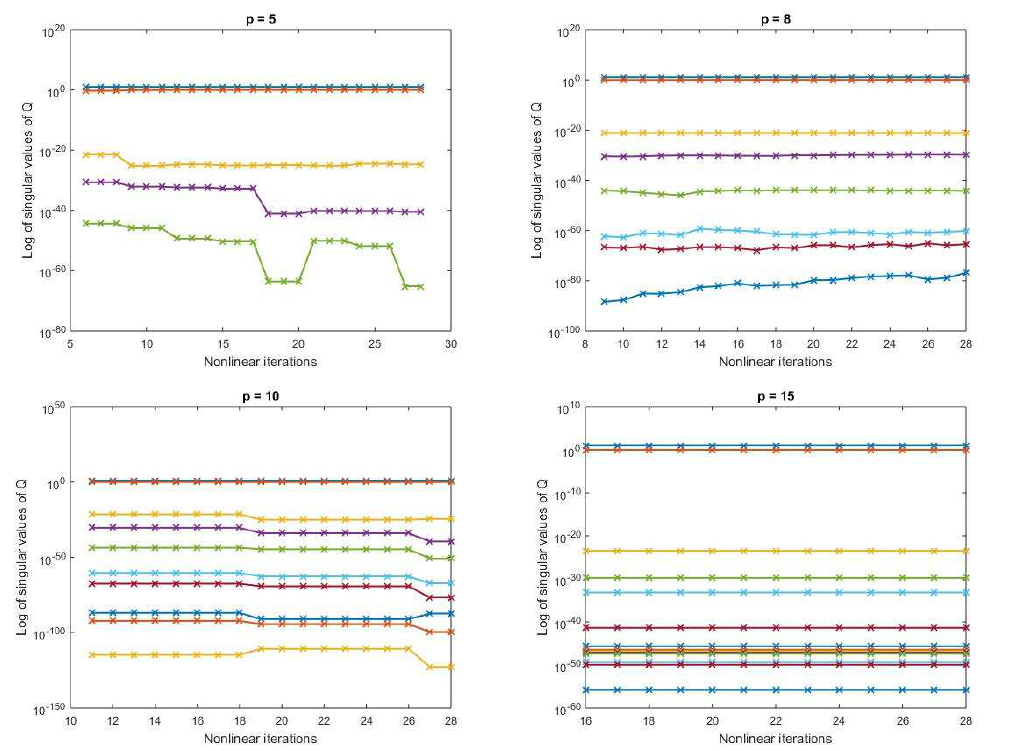
Figure 1. Singular values of the update matrix Q for p = 5 , 8 , 10 and p = 15 for Problem